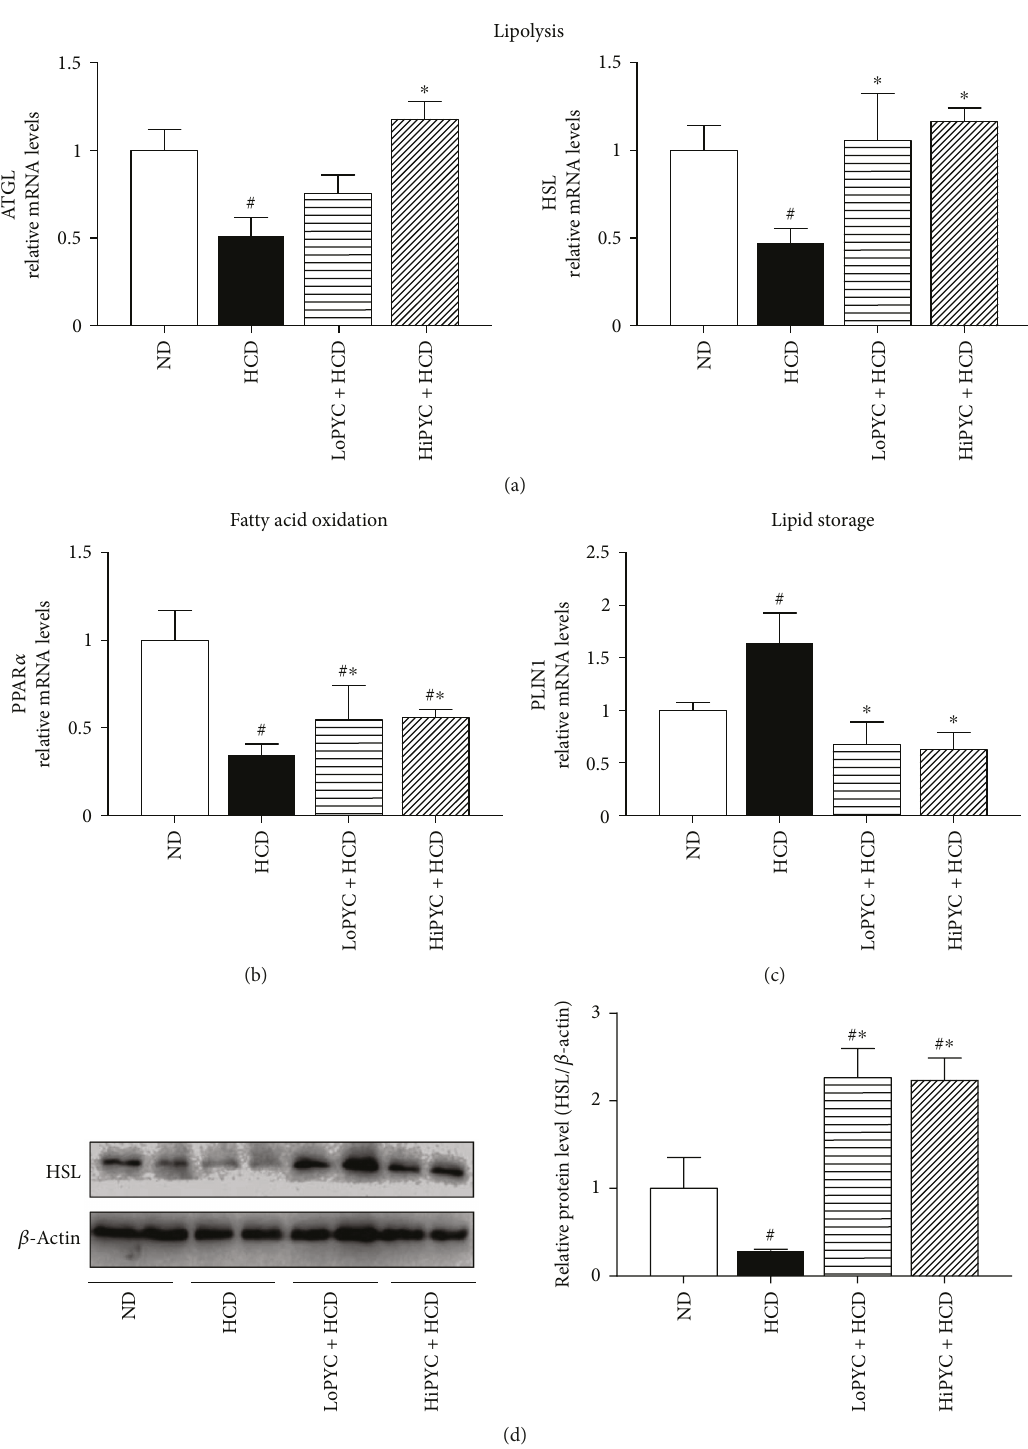
Figure 3: PYC altered the expression of genes related to lipid metabolism. (a) The mRNA levels of genes (ATGL and HSL) related to lipolysis; (b) the mRNA level of PPAR α (related to fatty acid oxidation); (c) the mRNA level of PLIN1; and (d) the protein level of HSL. The data are expressed as the means ± SE for 6 to 8 mice per group. # p < 0 05 versus the ND group; ∗ p < 0 05 versus the HCD